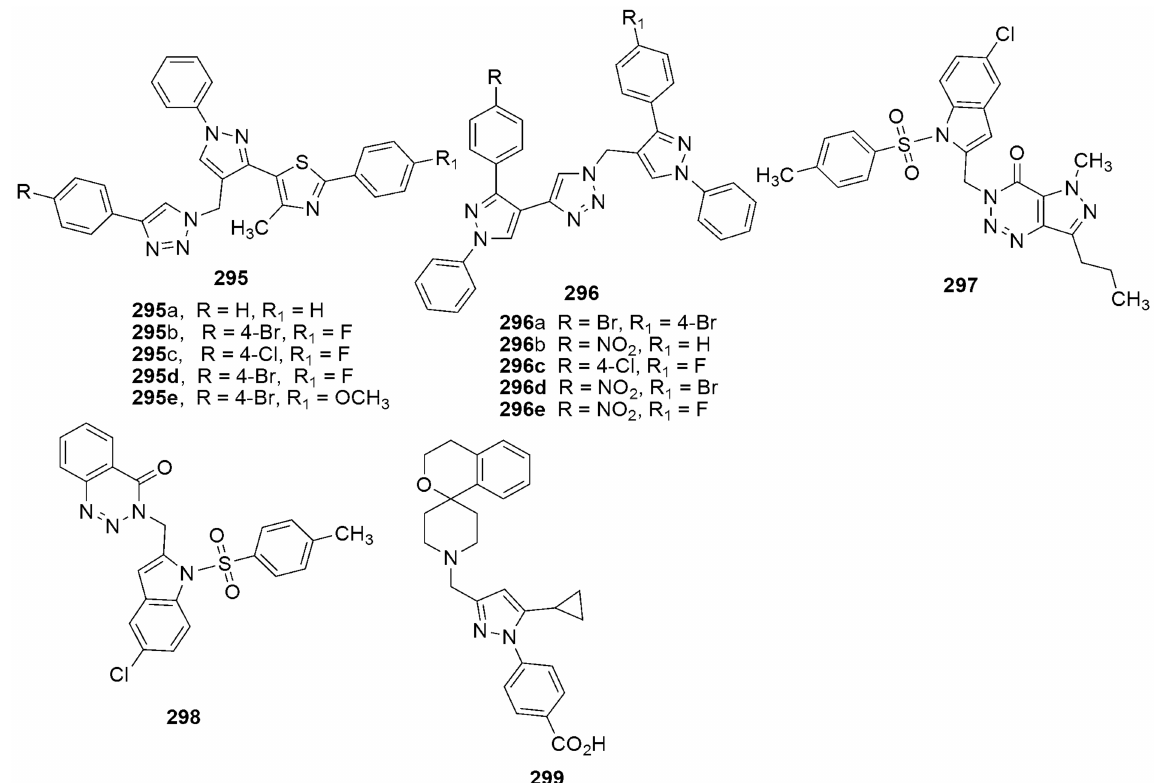
Figure 17. Structures of pyrazole hybrids with antitubercular